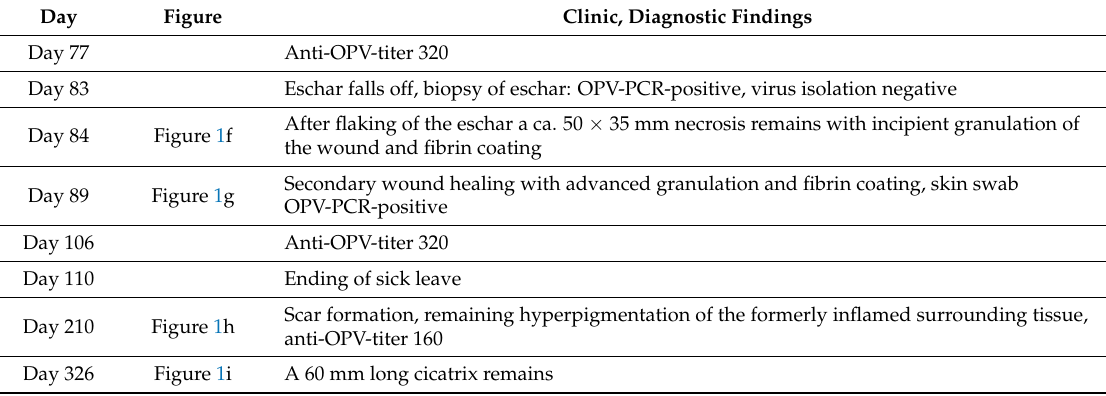
Figure Clinic, Diagnostic